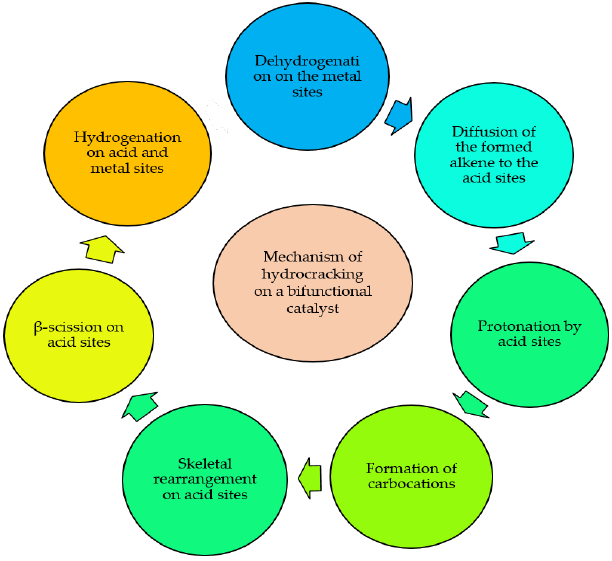
Figure 7. Schematic of hydrocracking steps on a bifunctional hydrogenation